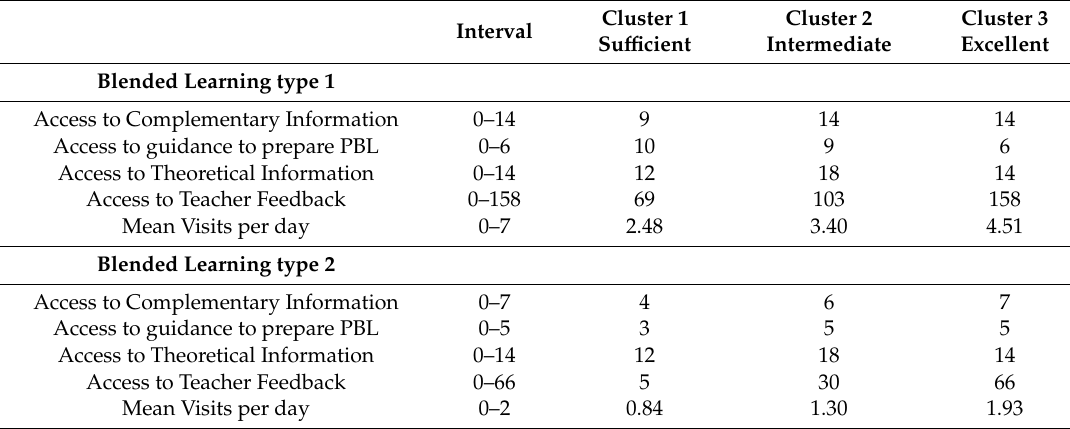
Table 6. Centers of final clusters and the variable behavioral learning on the LMS in Blended Learning type 1 and type 2. Blended Learning type 1: a lost value is observed. a n = 31; b n = 27; c n = 5;